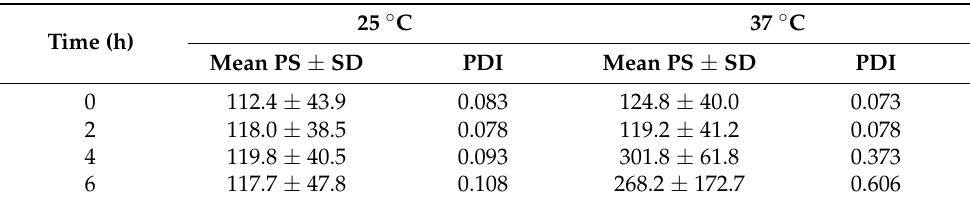
Table 1. The stability of NS suspension at different temperatures.